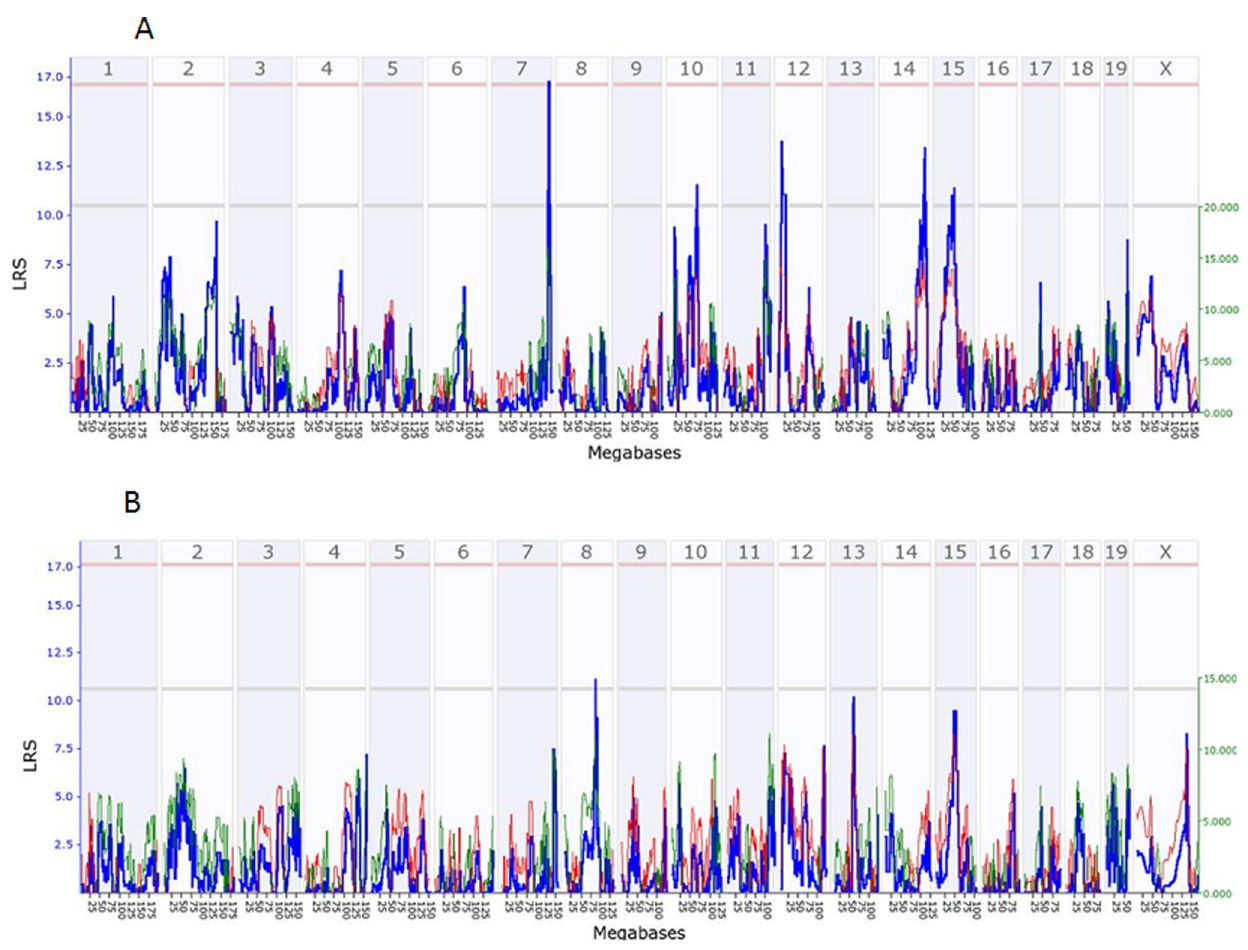
Figure 3. QTL on chromosome 15 detected from both sexes and from female mice. Interval mapping was conducted using age- and sex- adjusted BMD data and data of the femur of female mice. Figure 3A. QTL for BMD detected from data of mouse femur. Figure 3B. QTL for BMD detected from data of mouse tibia.